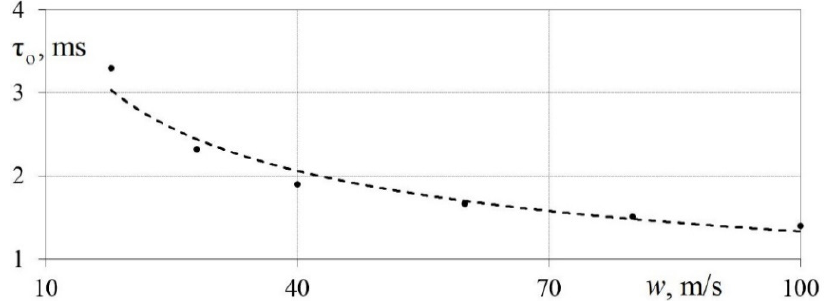
Figure 12. Dependence of the time constant τ o of the measuring system on the average air flow velocity w .